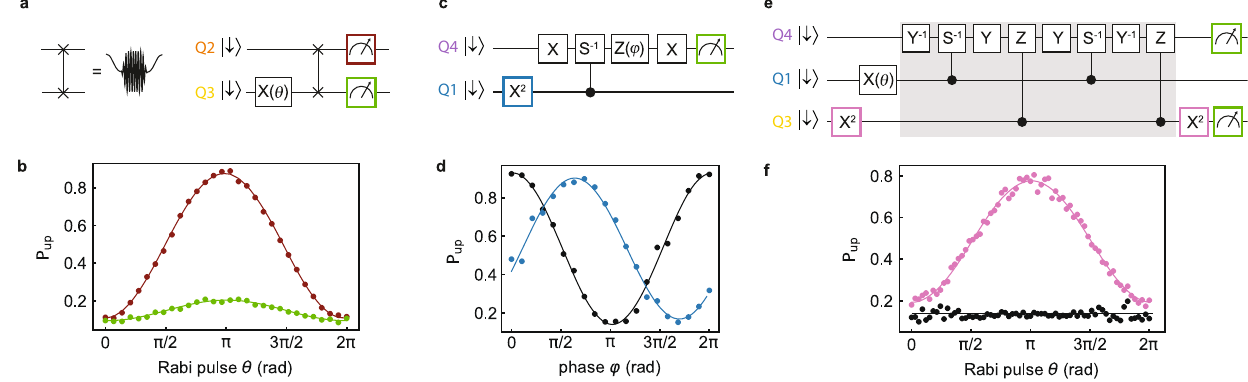
Fig. 3 SWAP, CS − 1 and Toffoli-like gate. a A resonant SWAP gate is implemented by applying a Tukey-shaped pulse with an oscillation superimposed to the barrier gate between Q2 and Q3. It is tested using the depicted circuit diagram. b To demonstrate the SWAP gate, a Rabi pulse X( θ ) is applied to Q3, followed by a SWAP gate between Q2 and Q3. Then, either Q2 is read out using readout system Q1Q2 (red) or Q3 is read out using readout system Q3Q4 (green). c Circuit diagram of the experiment demonstrating the CS − 1 gate. d The CS − 1 gate is obtained by calibrating the phase difference to be − π /2, for the experiments with (blue) and without (black) an X 2 gate on the control qubit Q1. e Circuit diagram of the Toffoli-like gate (gray) composed of CS − 1 and CZ gates. f Demonstration of the Toffoli-like gate with target qubit Q4 and control qubits Q1 and Q3. An X( θ ) pulse is applied to Q1 and the fi nal state of Q4 is measured using readout system Q3Q4. Results of the experiment in e with (pink) and without (black) a preparation pulse X 2 on ancilla qubit